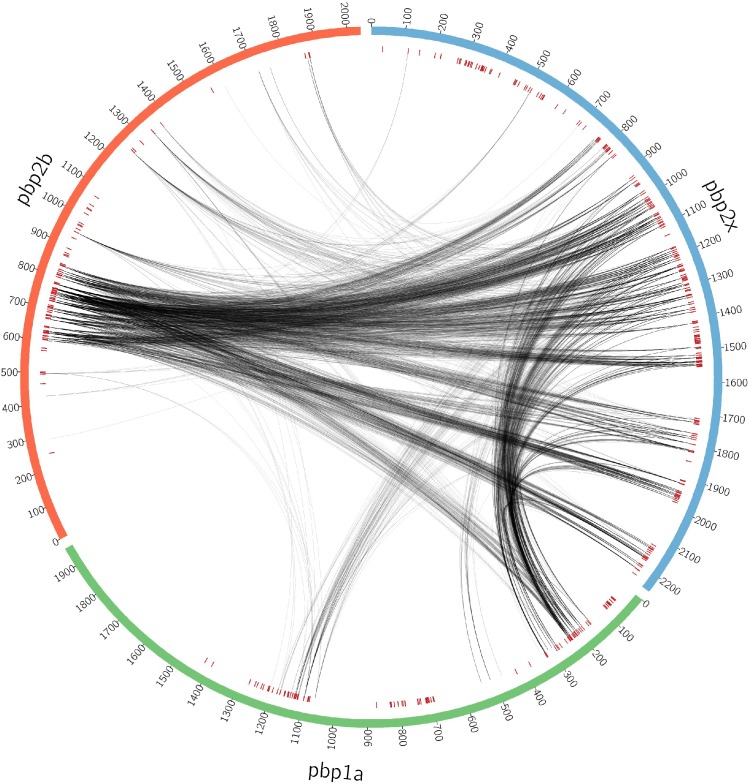
Distribution of couplings between sites in different PBPs.The red markers are defined as in Fig 2.